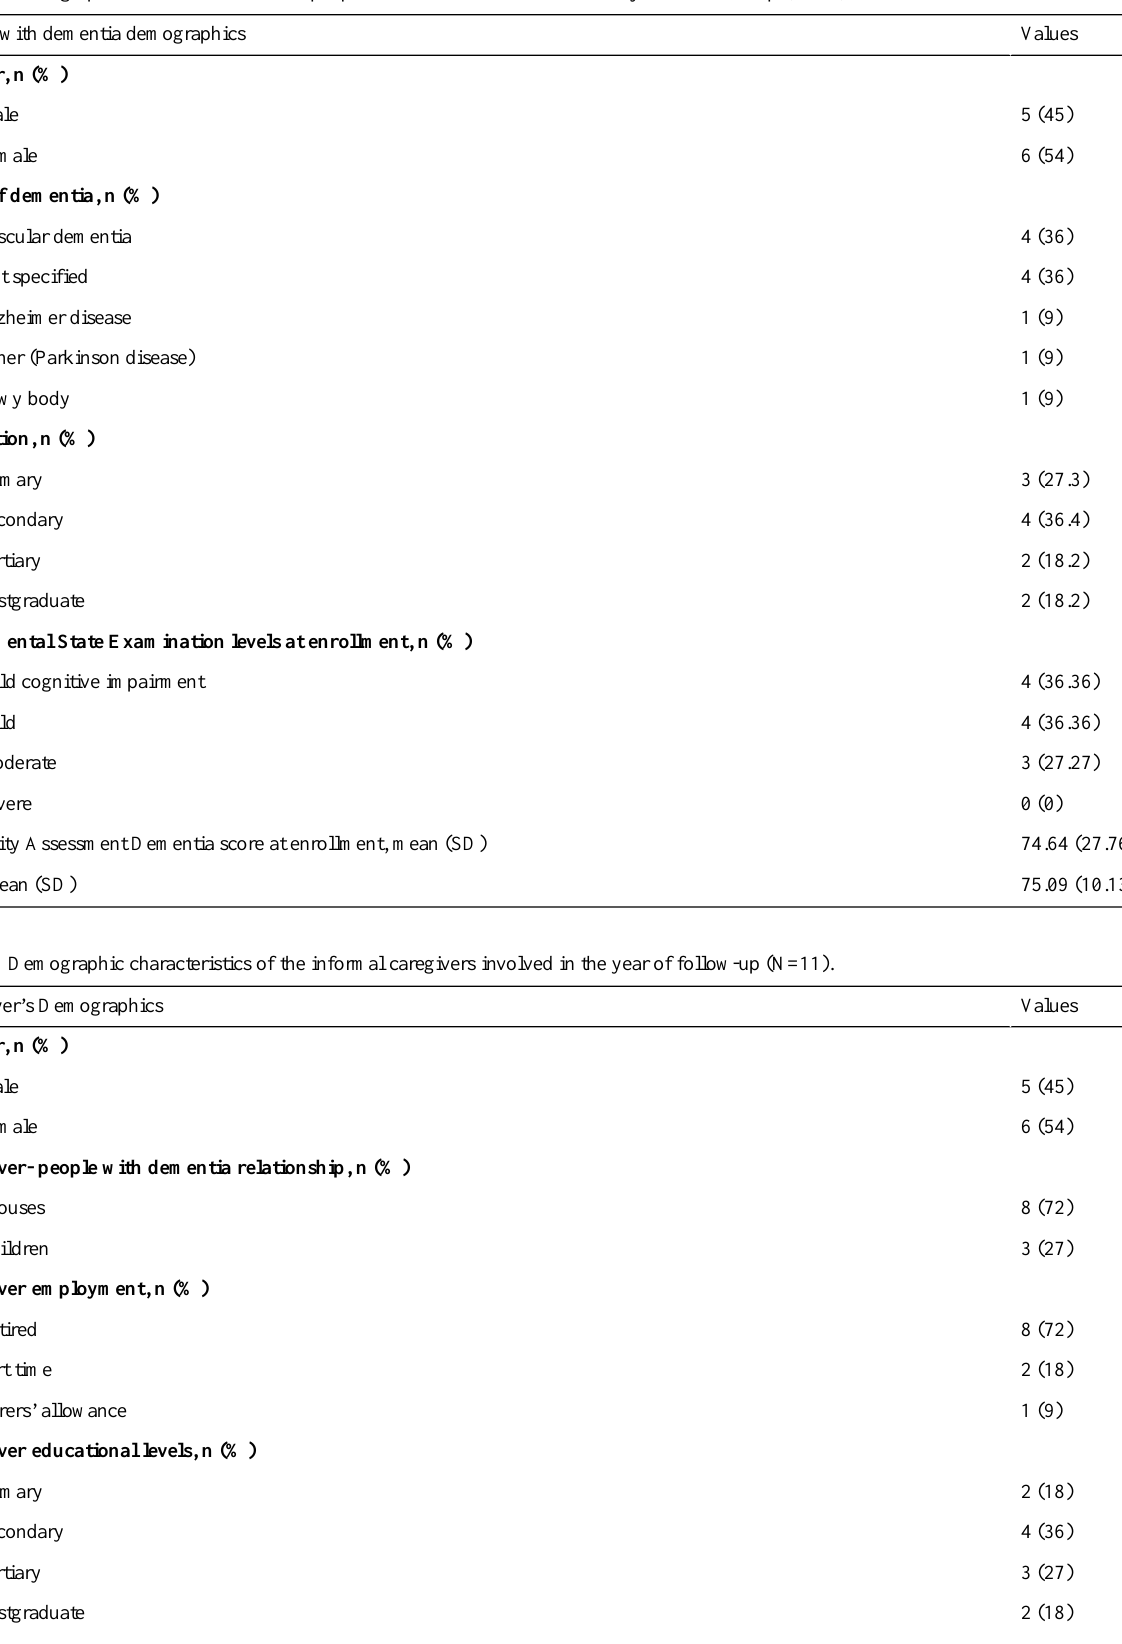
Table 4. Demographic characteristics of the people with dementia involved in the year of follow-up (N=11).